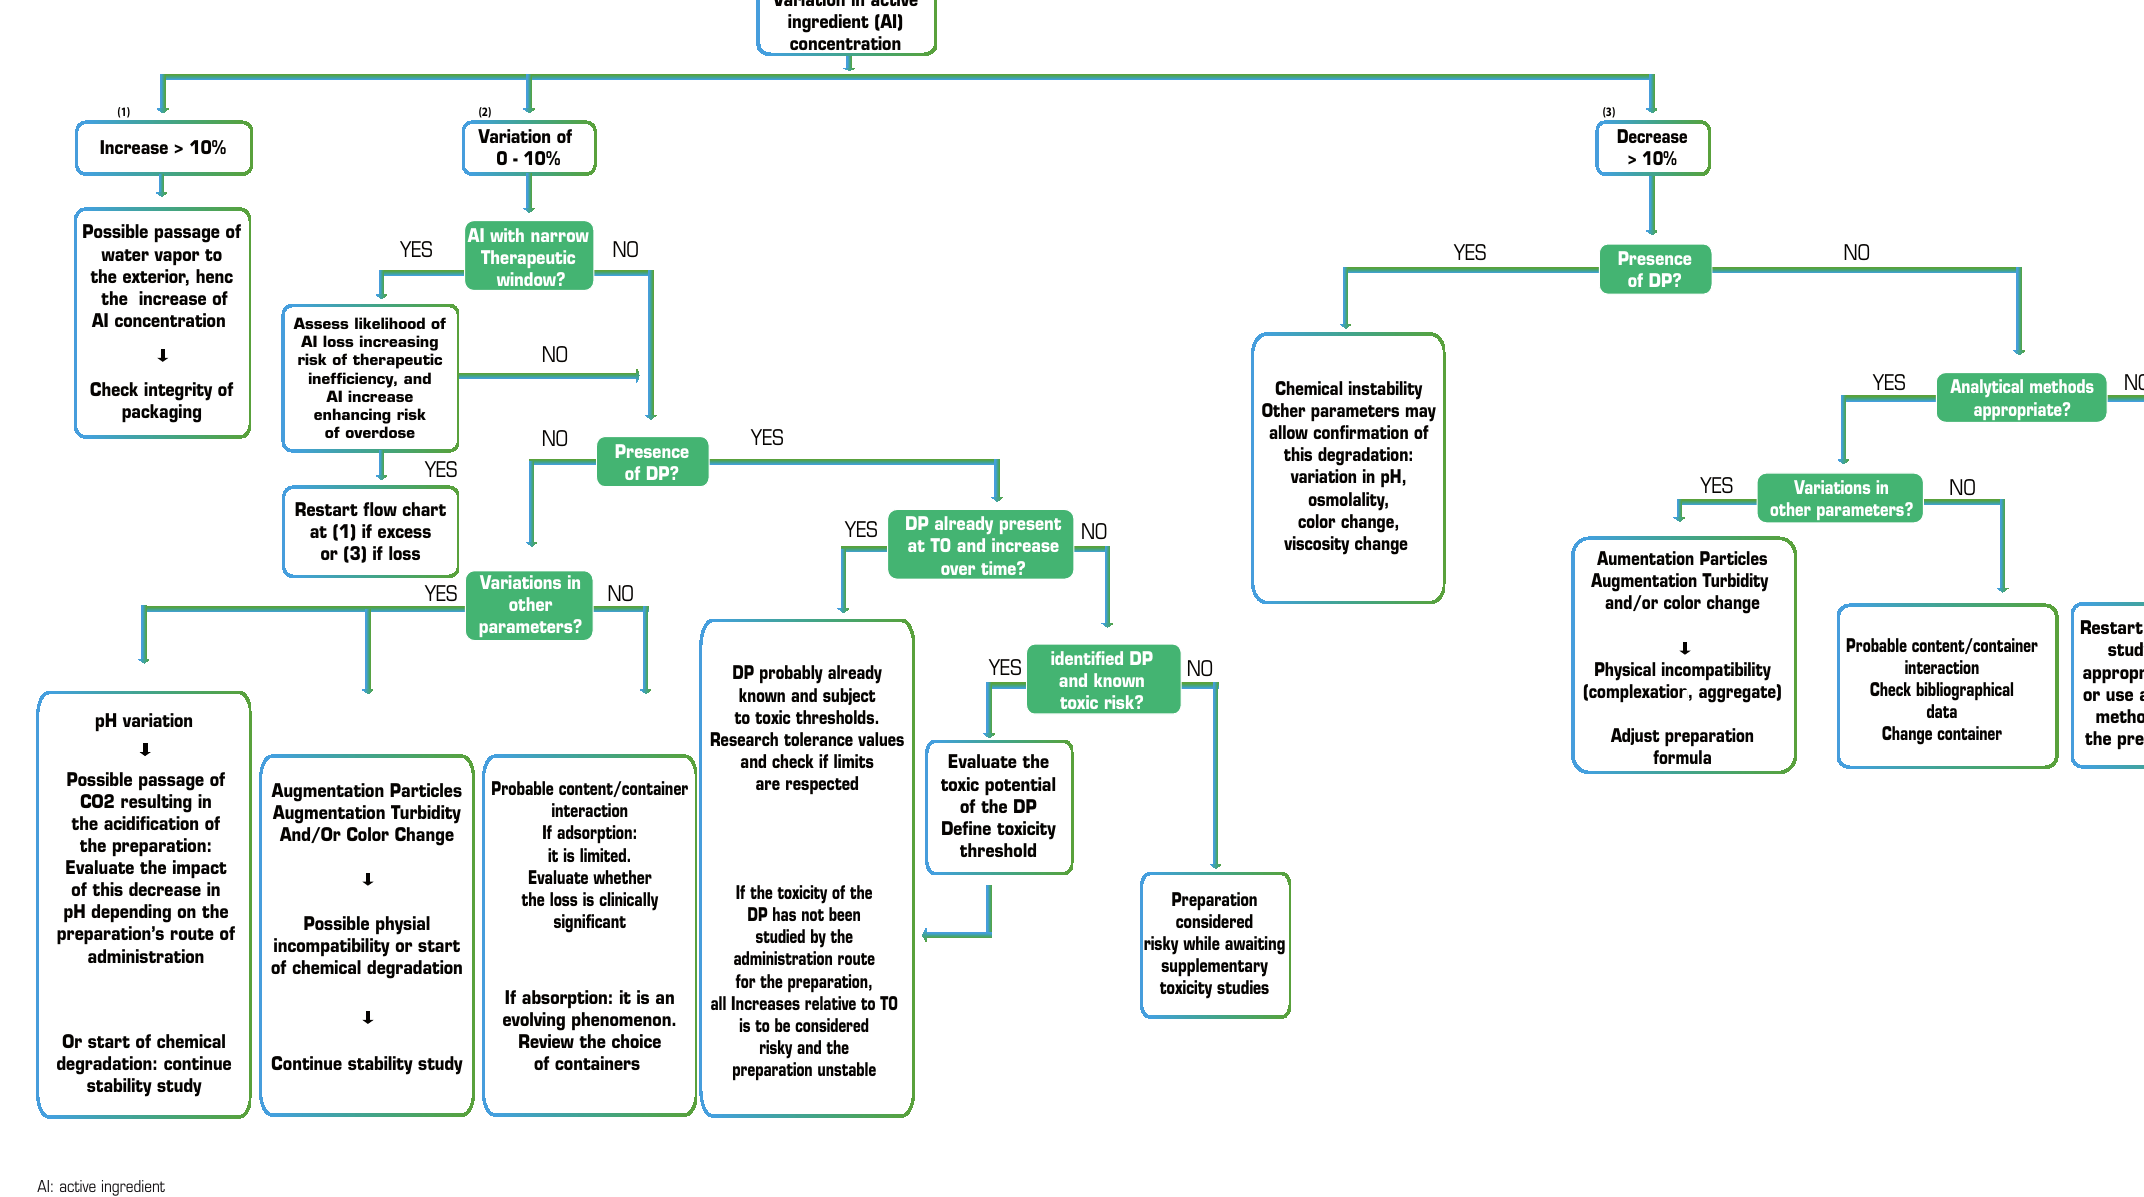
Figure 7: Helps interpreting the results of a stability study on a preparation in solution